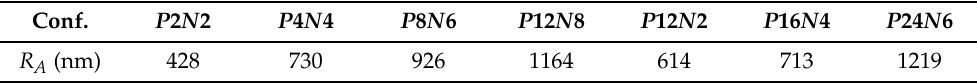
Table 2. Bi-burst mode processing for investigating surface roughness.